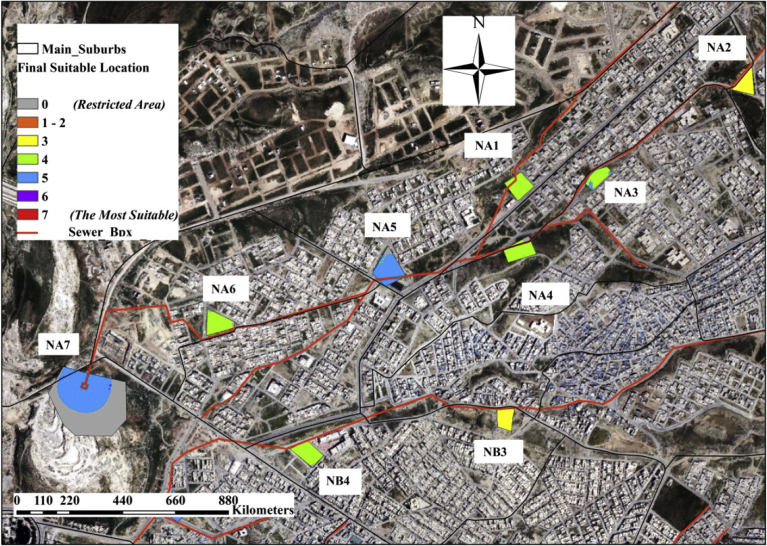
Suitability results of nominated areas NA1, NA2, NA3, NA4, NA5, NA6, NA7, NB3 and NB4.